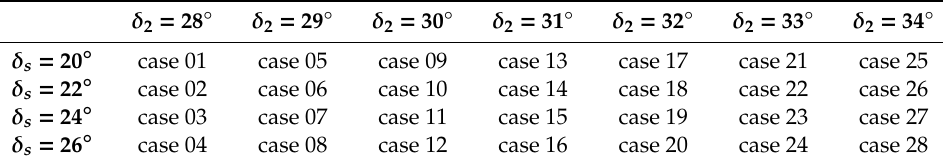
Table 2. Conditions of simulations for ping-pong ball flows.